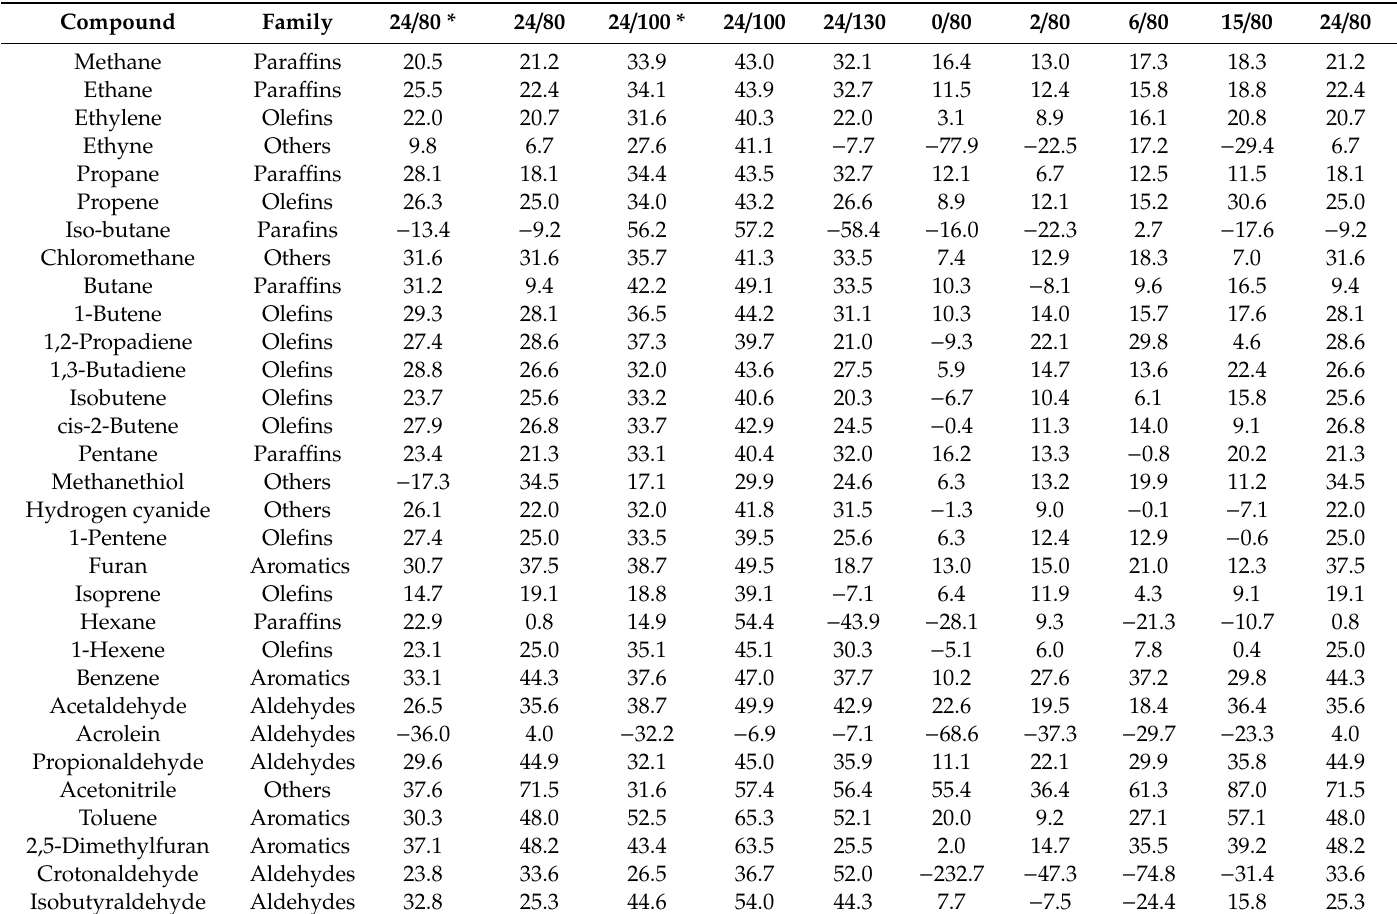
Table A1. Reduction percentages (%) of the di ff erent compounds identified in the gaseous fraction collected for the tobacco-catalyst mixtures respect to the 3R4F tobacco reference for the studies of time, temperature, and reduction of the supernatant liquor in the hydrothermal treatment. * Synthesis developed without reducing the supernatant liquor before the hydrothermal